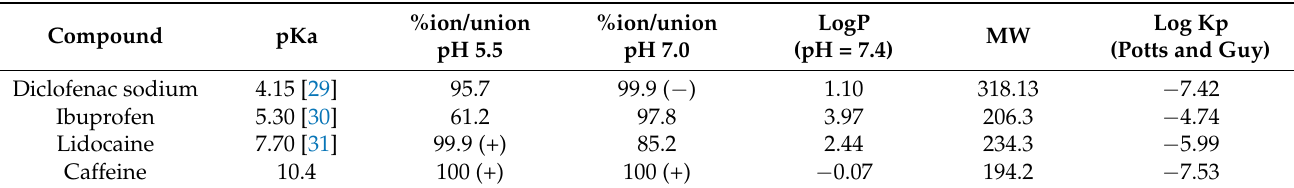
Log Kp %ion/union %ion/union LogP MW (Potts and Guy) pH 5.5 pH 7.0 (pH = 7.4)